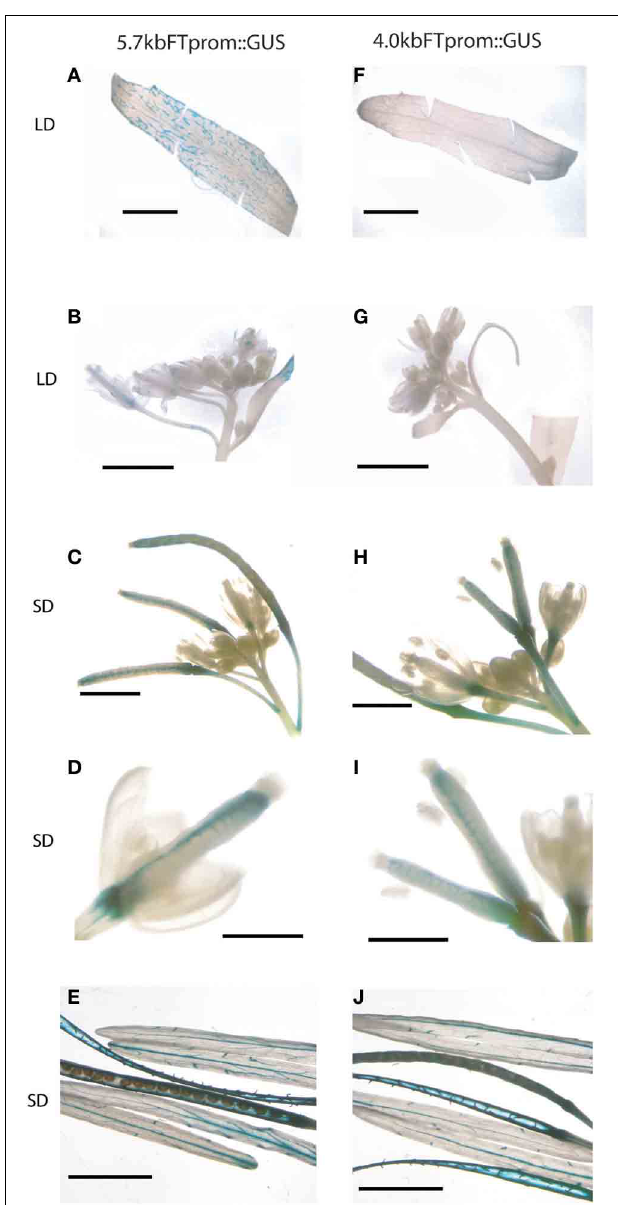
FIGURE 3 | GUS driven by 4kb FT promoter in siliques. Histochemical GUS assay of A–E 5.7kbFTp::GUS and F–H 4kbFTp::GUS plants in Col-0 background harvested after bolting. Samples were cauline leaves in LDs with cut margins to allow better infiltration of staining solution (A,F) , inflorescences grown in LD (B,G) , and SDs (C,H) , young siliques (D,I) and mature siliques grown in SDs (E,J) . Scale bars 5mm, except (D,I) :